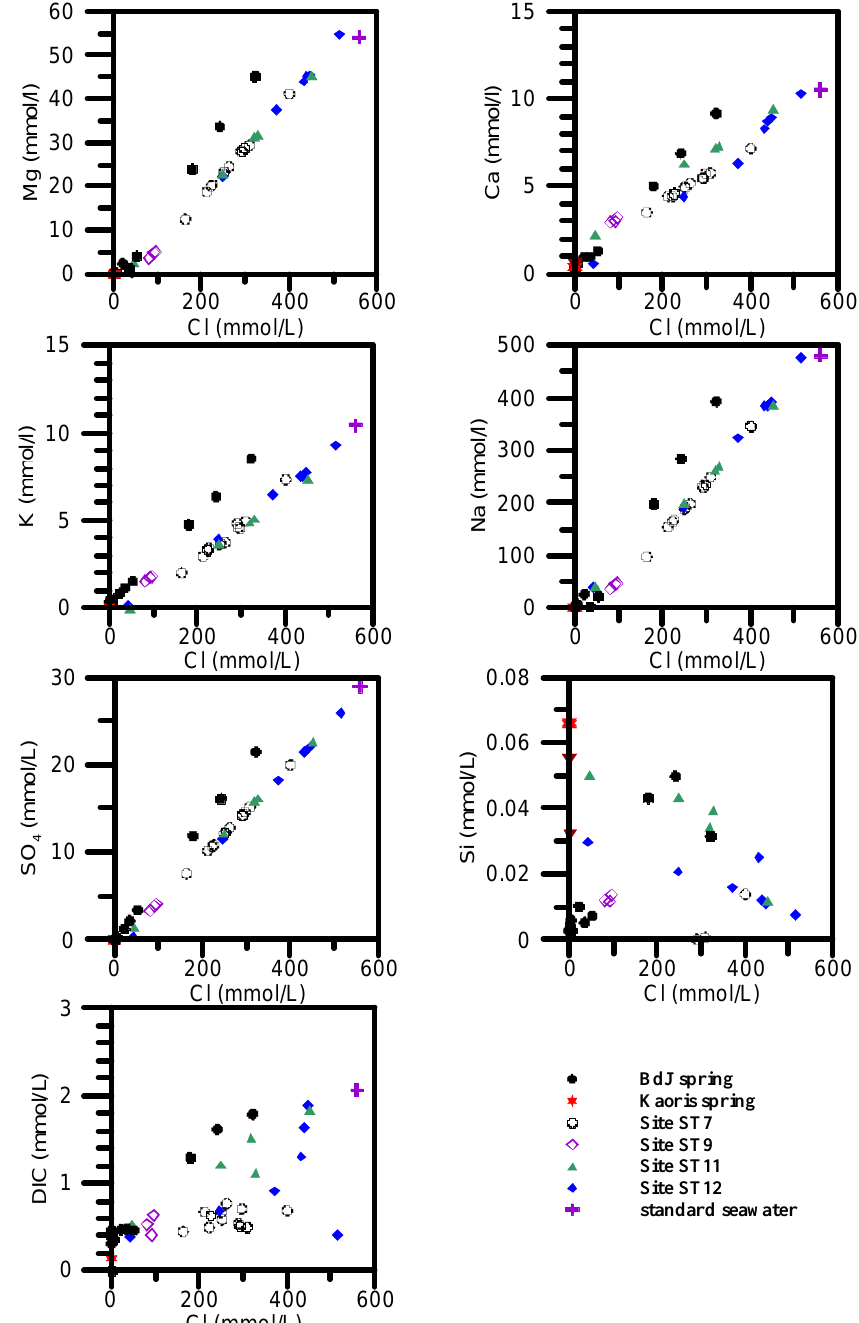
Figure 5. Element concentrations versus the chloride content of the water samples (cross: standard seawater; open circles: Site ST07 (Aiguille de Prony); filled diamonds: Site ST12; open diamonds: Site ST09; triangles: Site ST11; filled circles: Bain des Japonais; star: Rivière des Kaoris; inverted triangle: data from Launay and Fontes (1985) for the Bain des Japonais and the Rivière des Kaoris.